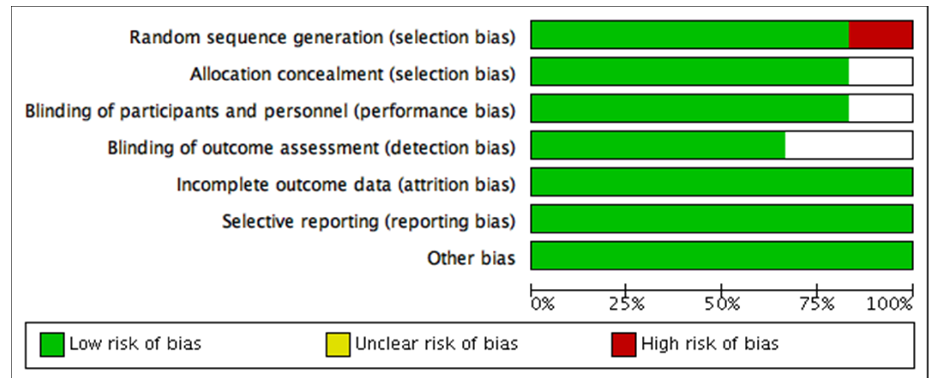
Figure 3. Risk of bias graph: review authors’ judgements about each risk of bias item presented as percentages across all included studies.